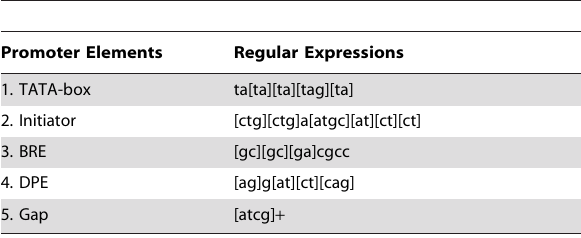
Table 2. Regular expressions of different promoter elements which give the terminal set.